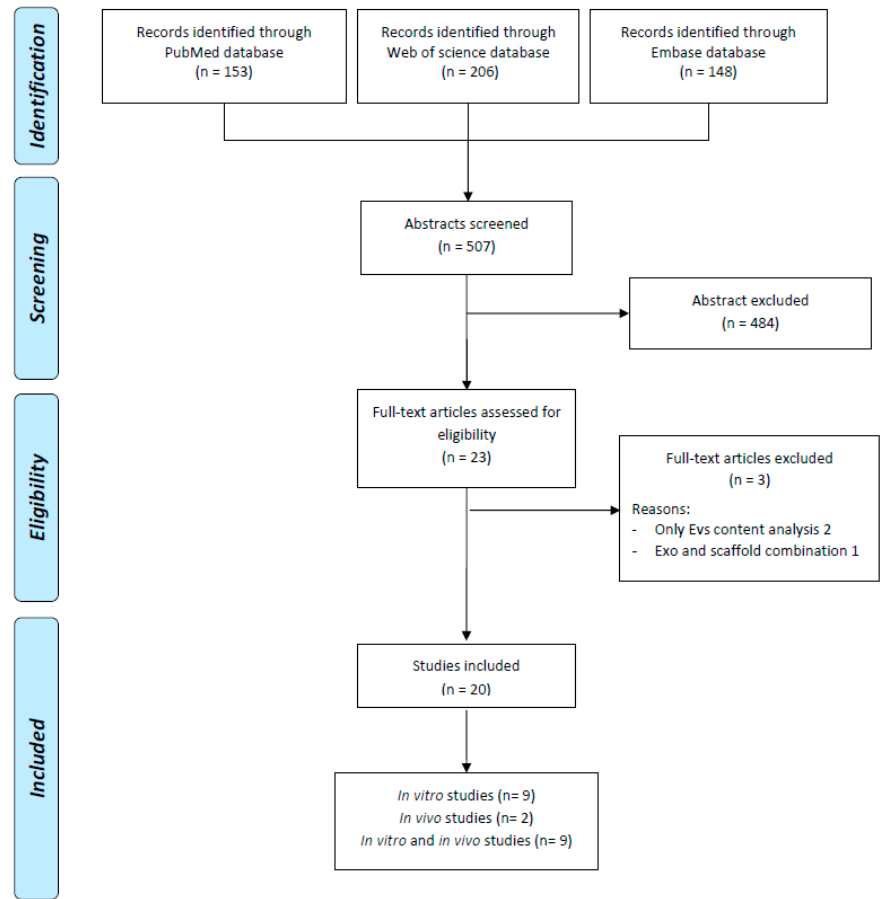
Figure 1. PRISMA (Preferred Reporting Items for Systematic Reviews and Meta-Analysis) flowchart of the systematic literature review.